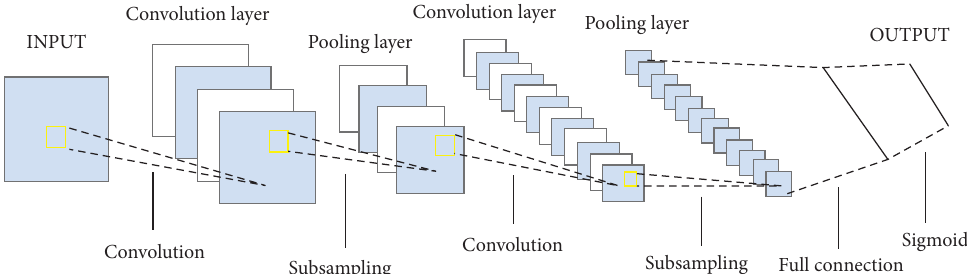
Figure 1: Structure diagram of convolutional neural network.